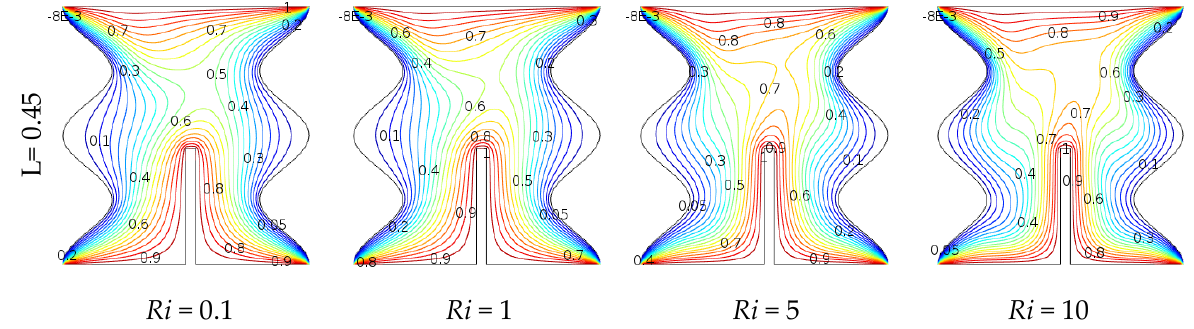
Figure 5. Isotherms for various Ri and L at Re = 100, Ha = 10, and λ = 2.